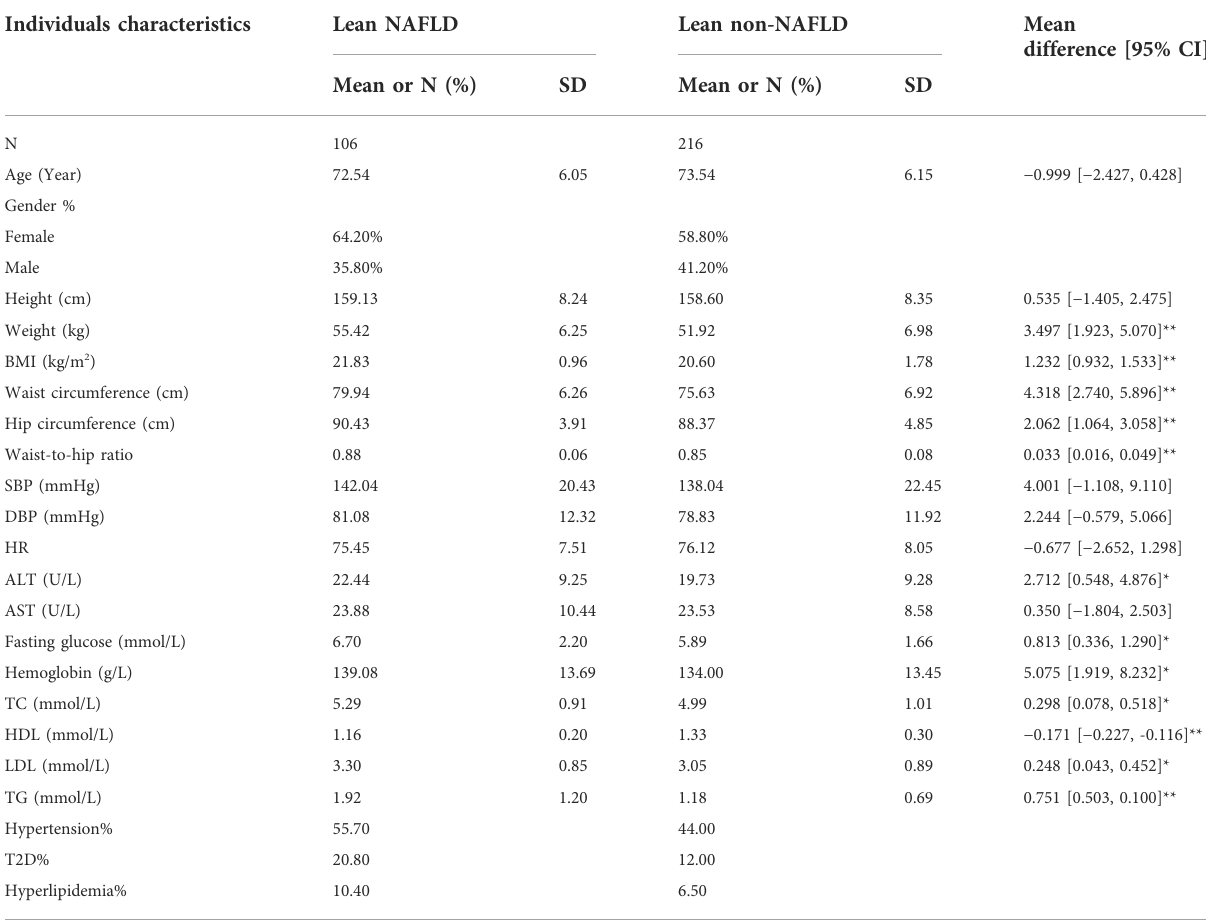
TABLE 1 Characteristics of lean NAFLD and non-NAFLD individuals. Individuals